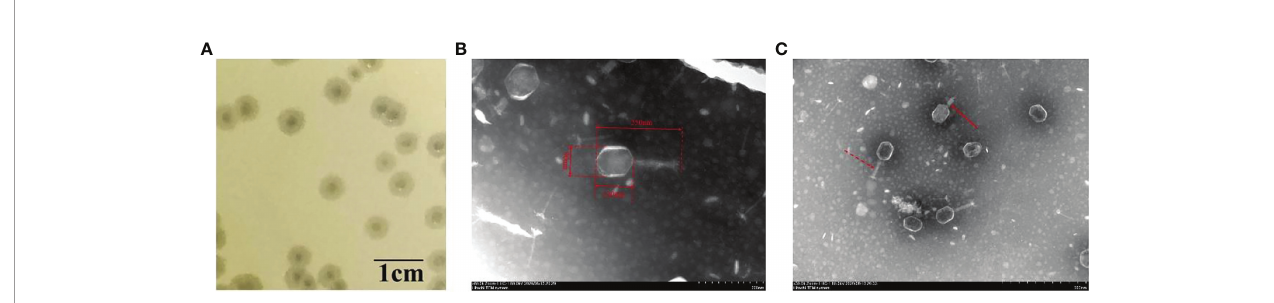
FIGURE 1 | Plaques and transmission electron microscopy of phage vB_kpnM_17-11. (A) Plaque morphology of phage vB_kpnM_17-11 on a bacterial lawn of K. pneumoniae 17-11 in nutrient broth with 0.5% agar (scale bar = 1 cm). (B) Transmission electron microscopy of phage vB_kpnM_17-11. (C) Contractive and non-contractive tails. Dashed arrow for non-contractile tail; Solid arrow for contractile tail.